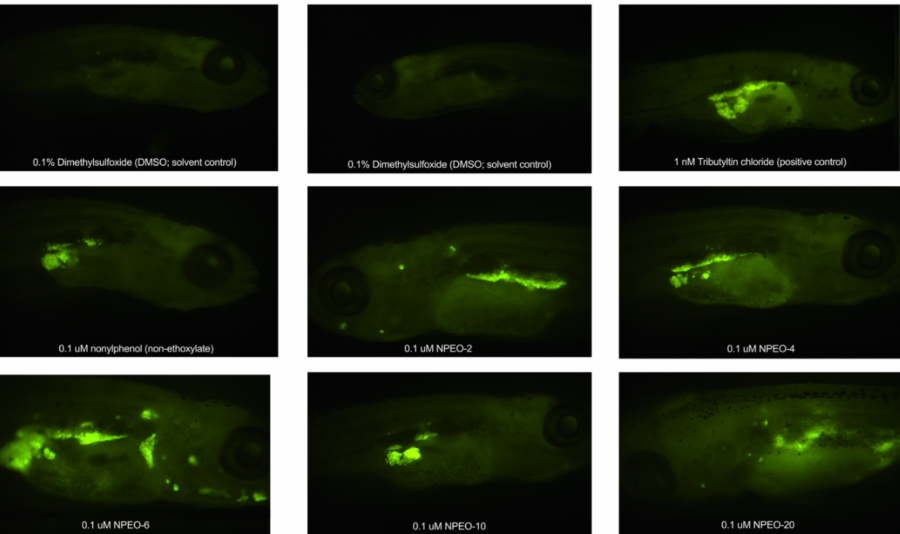
Figure 6. Adipose Patterning in Zebrafish Developmentally Exposed to Nonylphenol and Polyethoxy- lates. Representative fluorescent images of developmentally exposed zebrafish exposed to control chemicals, nonylphenol, and the nonylphenol polyethoxylates. Anesthetized fish imaged at 30 days post-fertilization, following a 30 min stain (0.5 µ g/mL Nile Red). Images obtained at 16 × magnification using a yellow fluorescent protein filter. DMSO = dimethylsulfoxide, vehicle control; TBT = tributyltin chloride; NPEO = nonylphenol polyethoxylated (with varying average ethoxylate chain